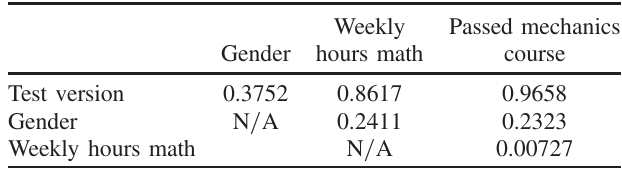
TABLE II. p values for chi-squared tests on each pair of the variables test version, gender, weekly hours math, and passed mechanics course. All pairs can be assumed to be independent, except weekly hours math and passed mechanics course.